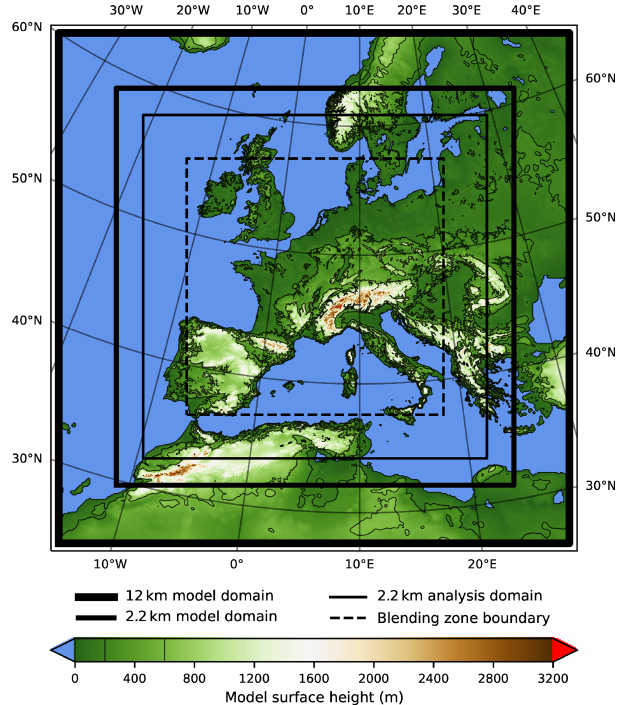
Figure 1. Domain boundaries and model topography of the two COSMO simulations. The four black boxes show, from large to small, (bold) the model domain of the driving simulation with a hor- izontal grid spacing of 12km, (semibold) the model domain of the nested simulation with a horizontal grid spacing of 2.2km, (thin) the subdomain of the 2.2km domain on which the precipitation at- tribution analysis is performed, and (dashed) the inner boundary of the blending zone that is used during the computation of the hybrid fields on which the feature identification is based (see Sect. 2.1). The model topography inside (outside) the 2.2km domain bound- ary is that of the nested 2.2km (driving 12km)